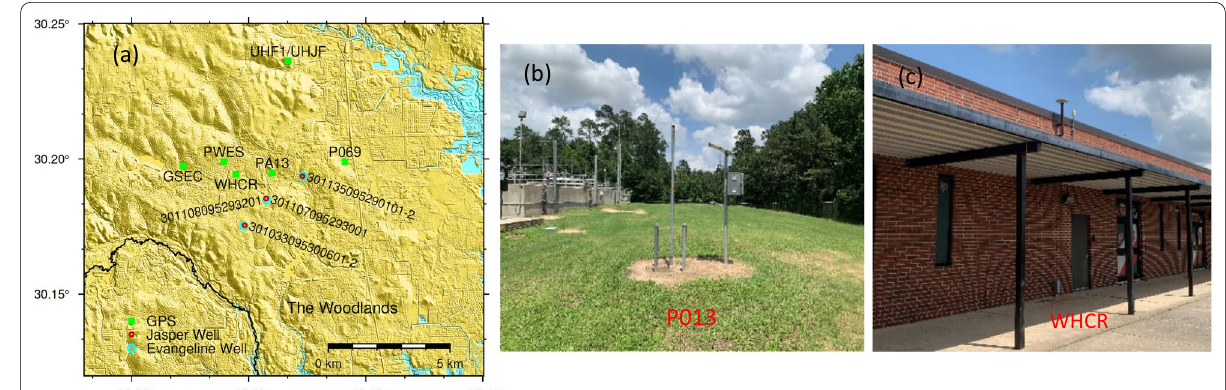
Fig. 12 a Map showing the locations of GPS and groundwater-level observation wells in The Woodlands area; b the permanent GPS antenna pole and solar power system at P013; c GPS antenna WHCR, which is located in The Woodlands High School. The LiDAR data for plotting the DEM map is available at NOAA (https:// coast. noaa. gov/ datav